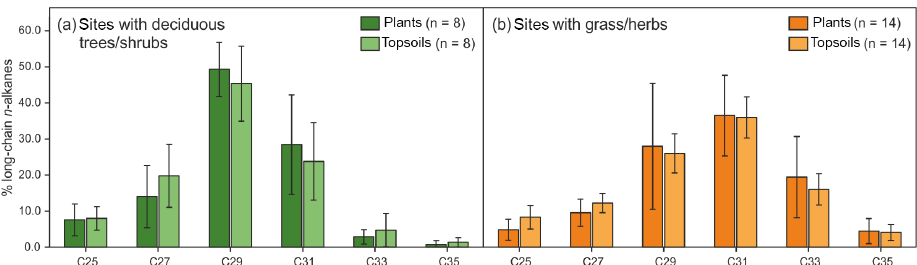
Figure 4. Chain length distribution patterns for long-chain n -alkanes in modern plants and topsoils from sites with (a) deciduous trees/shrubs, and (b)